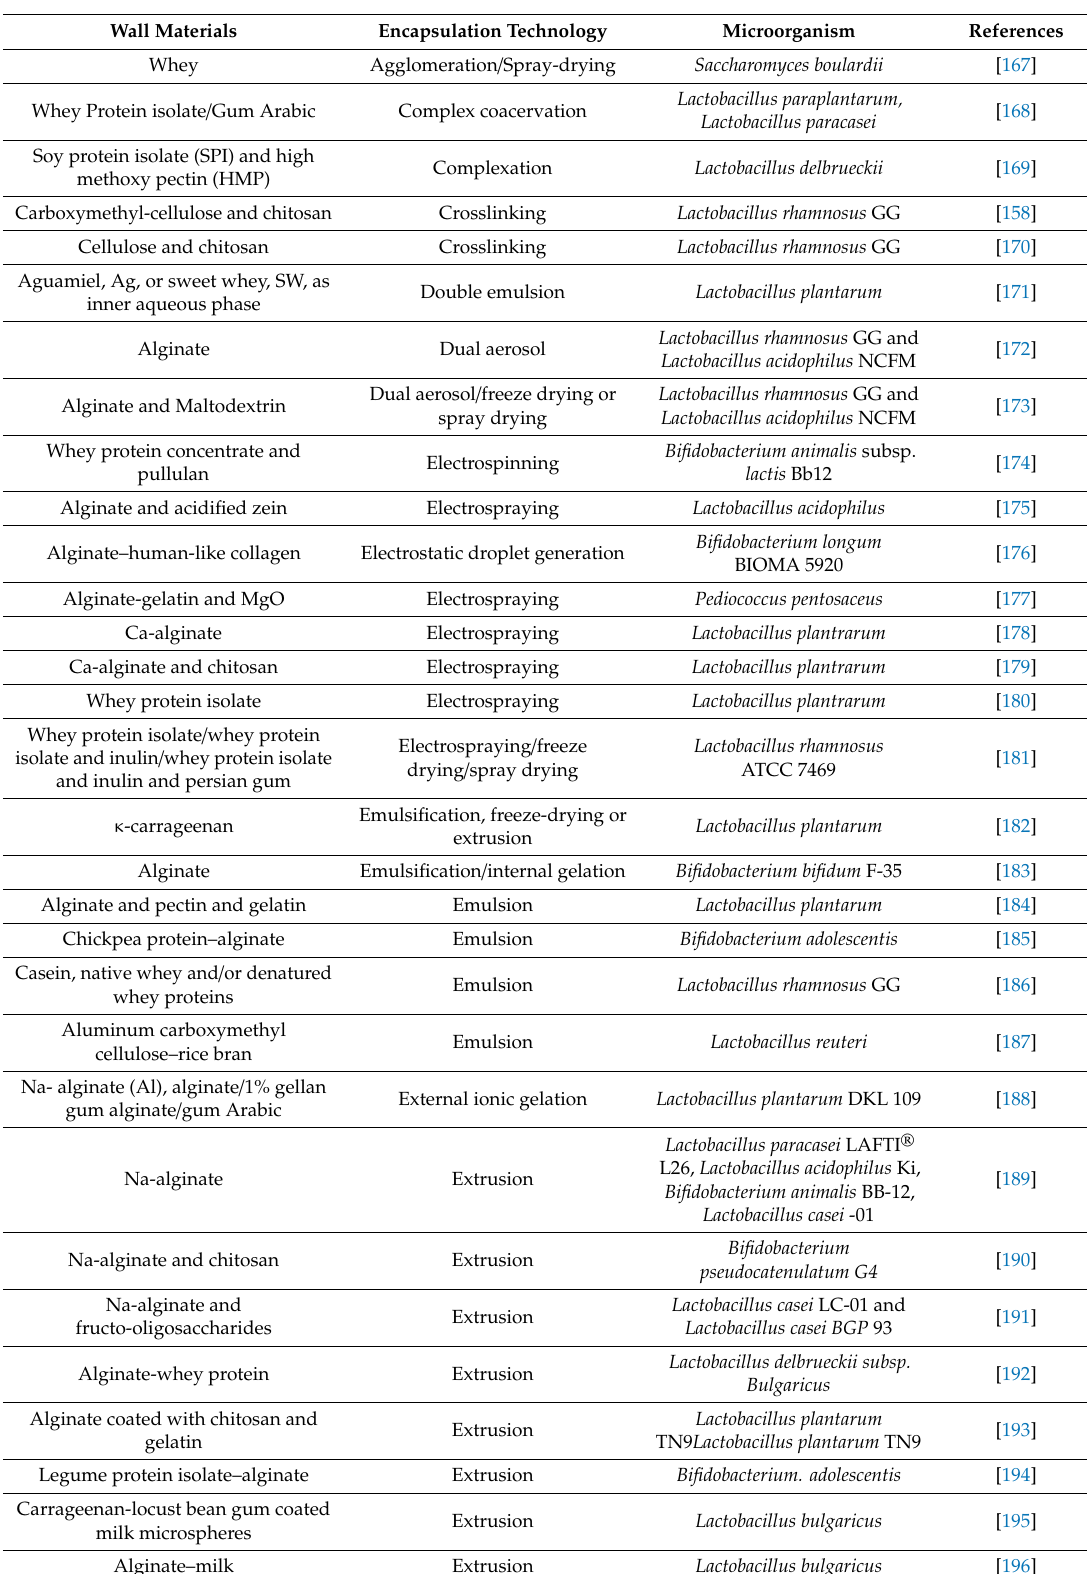
Table 1. Advances in combinations of wall materials and technologies for the microencapsulation of probiotic